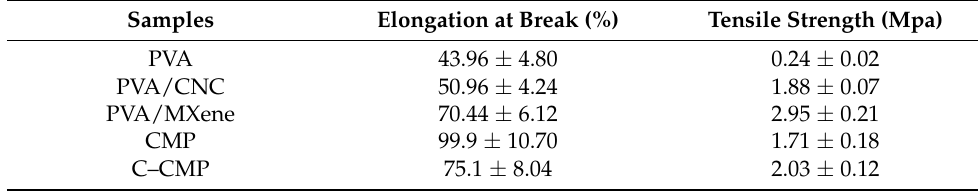
Table 1. Tensile data of different